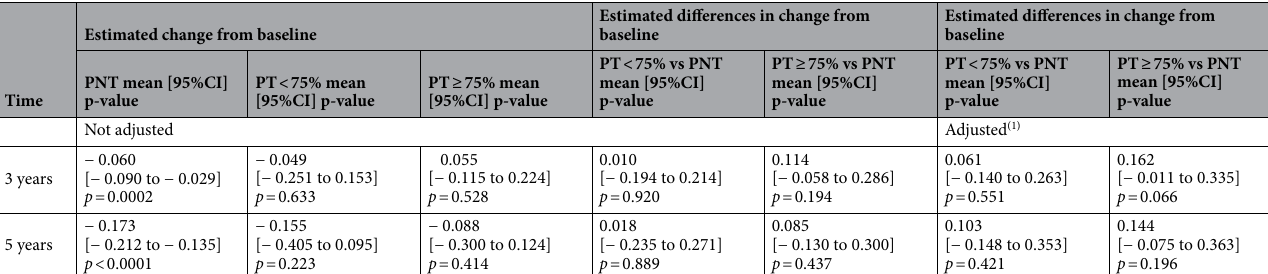
Estimated differences in change from baseline